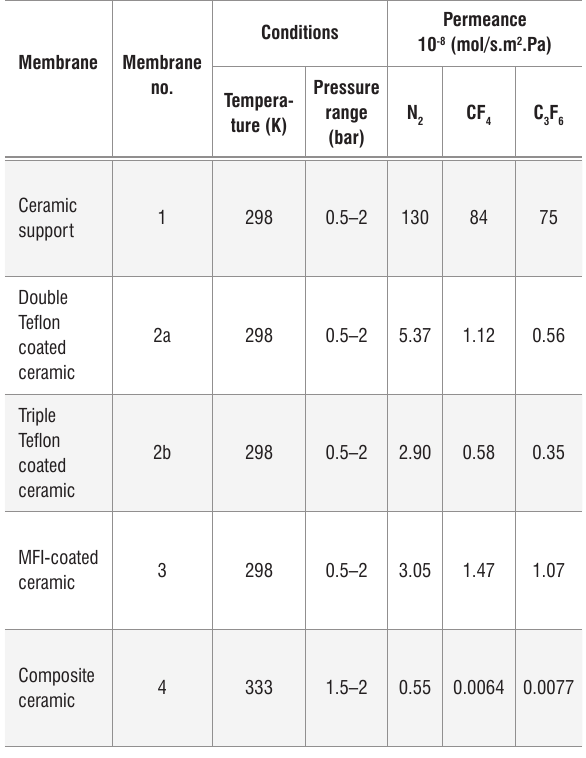
Summary of the single gas permeance values for the various membranes